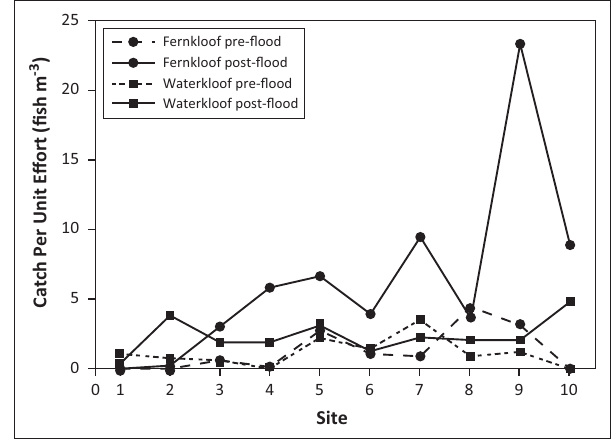
FIGURE 3: Pre-flood and post-flood longitudinal abundance trends for Pseudobarbus afer catch per unit effort (fish m -3 ) from the Waterkloof and